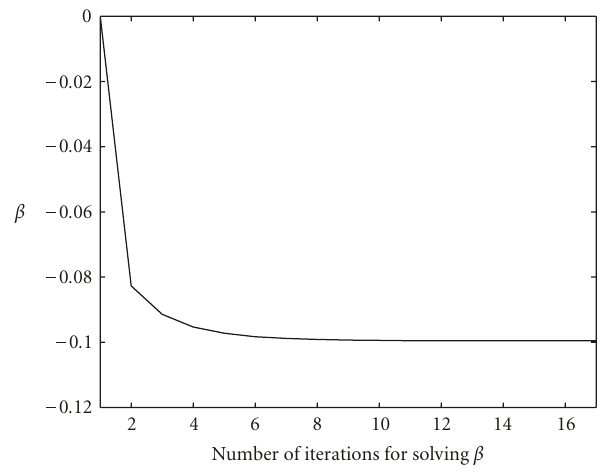
Figure 3: Typical convergence pattern of β